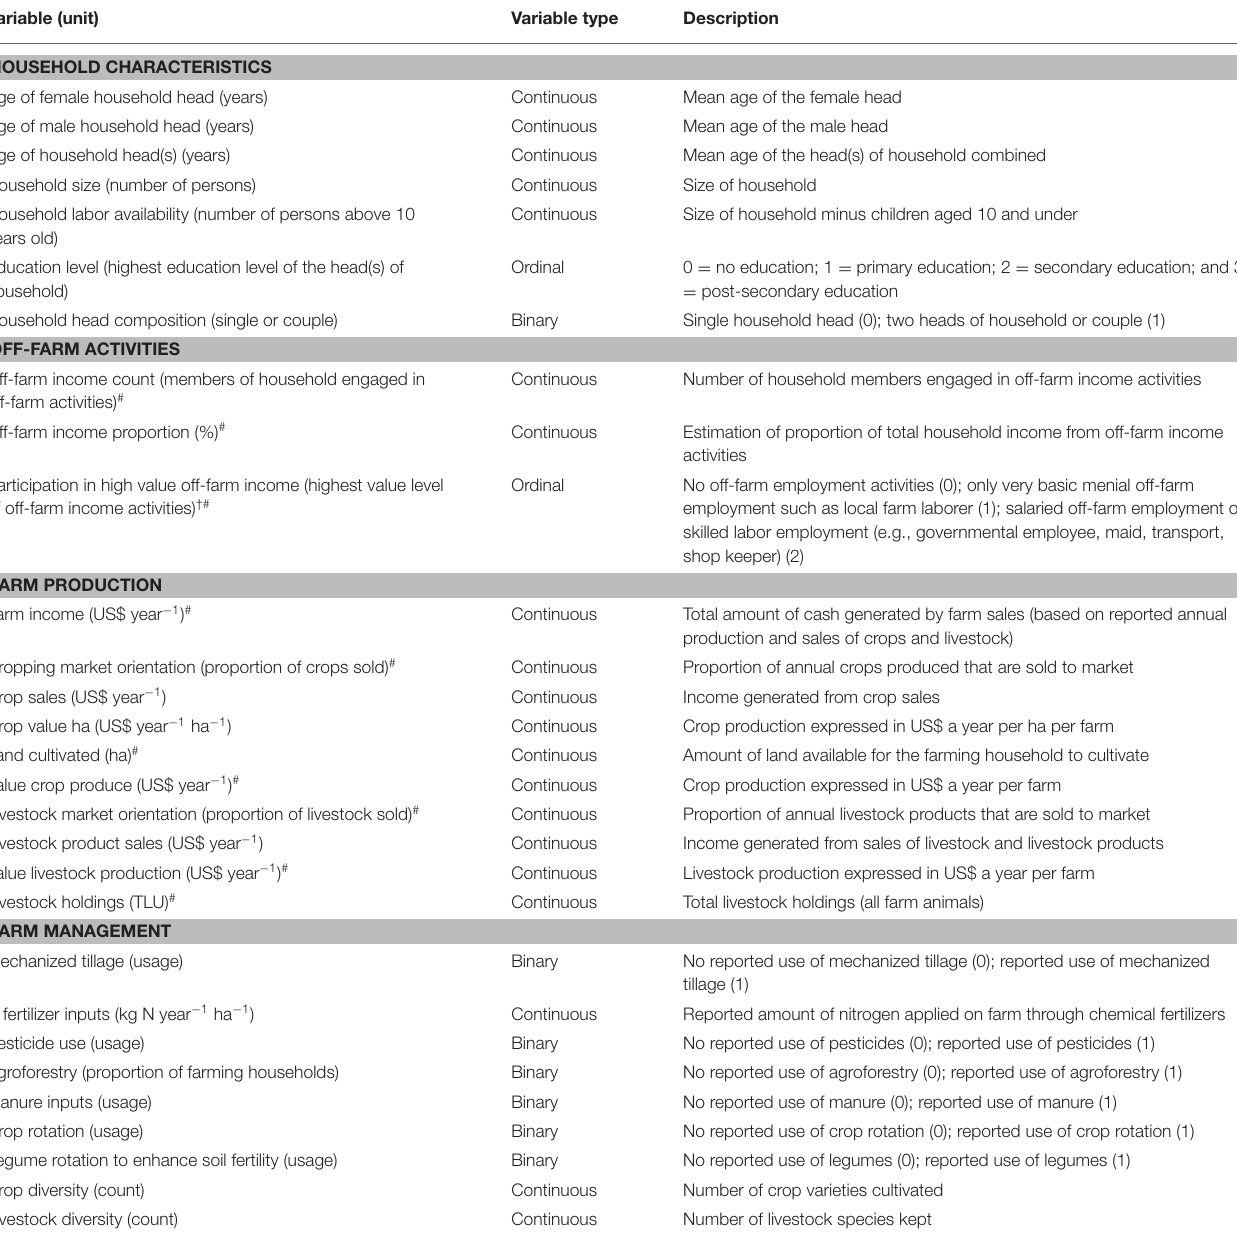
TABLE 1 | Description of variables collected by the RHoMIS survey used to assess the associations between household characteristics, farm production, and farming management collected in rural Andean communities in three South American